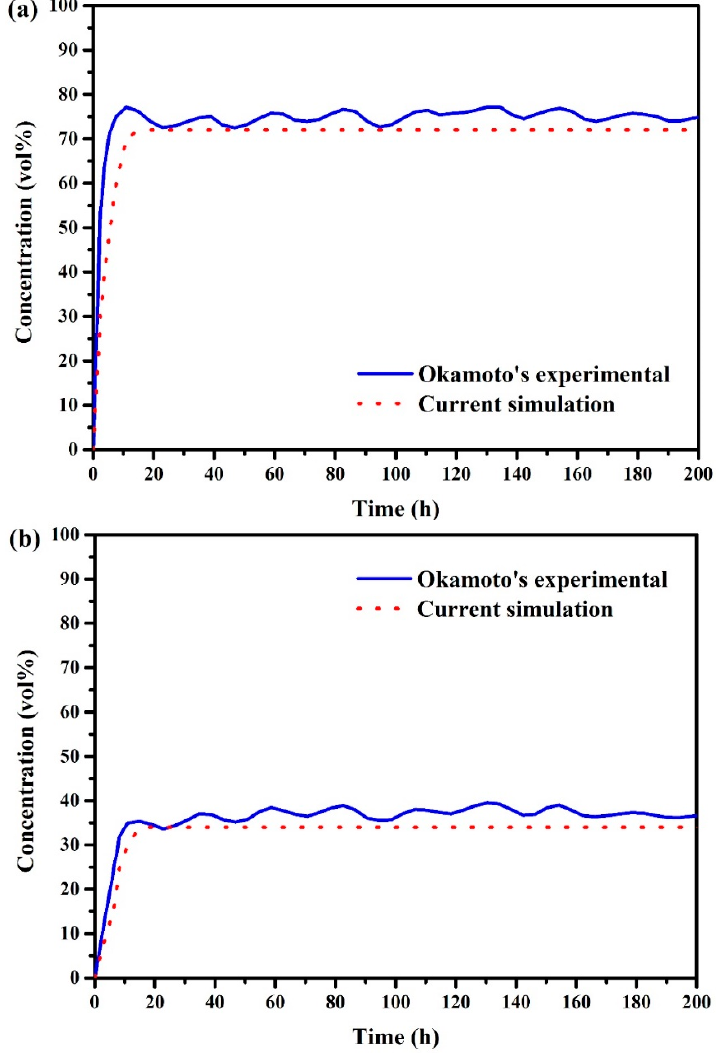
Figure 3. ( a ) CH 4 concentration comparison at Coordinate A. ( b ) CH 4 concentration comparison at Coordinate B.